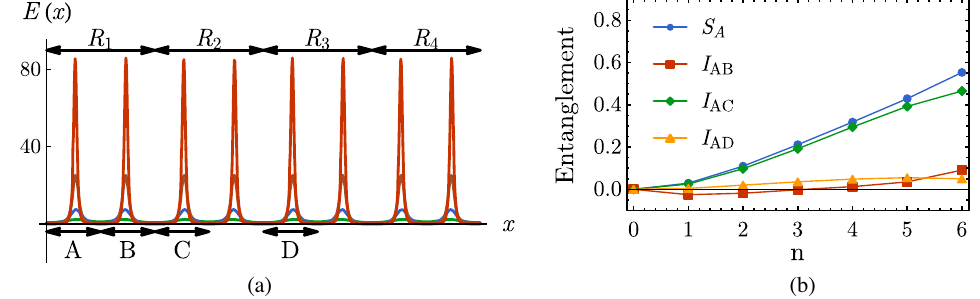
FIG. 14. (a) CFT calculation for the energy density. The system size is L ¼ 2 π , and the central charge c ¼ 1 . We choose q ¼ 4 , and T 0 ¼ 0 . 92 L=q and T 1 ¼ 0 . 1 L=q so that the system is in the heating phase. (b) Lattice calculation for the mutual information. We simulate complex free fermion on a 502-site chain, q ¼ 4 , T 0 ¼ 0 . 92 L=q , and T 1 ¼ 0 . 1 L=q . The choice of subsystem A , B , C , or D is consistent with (a). All the quantities are subtracted by their initial values. The data for n > 6 are spoiled by the lattice